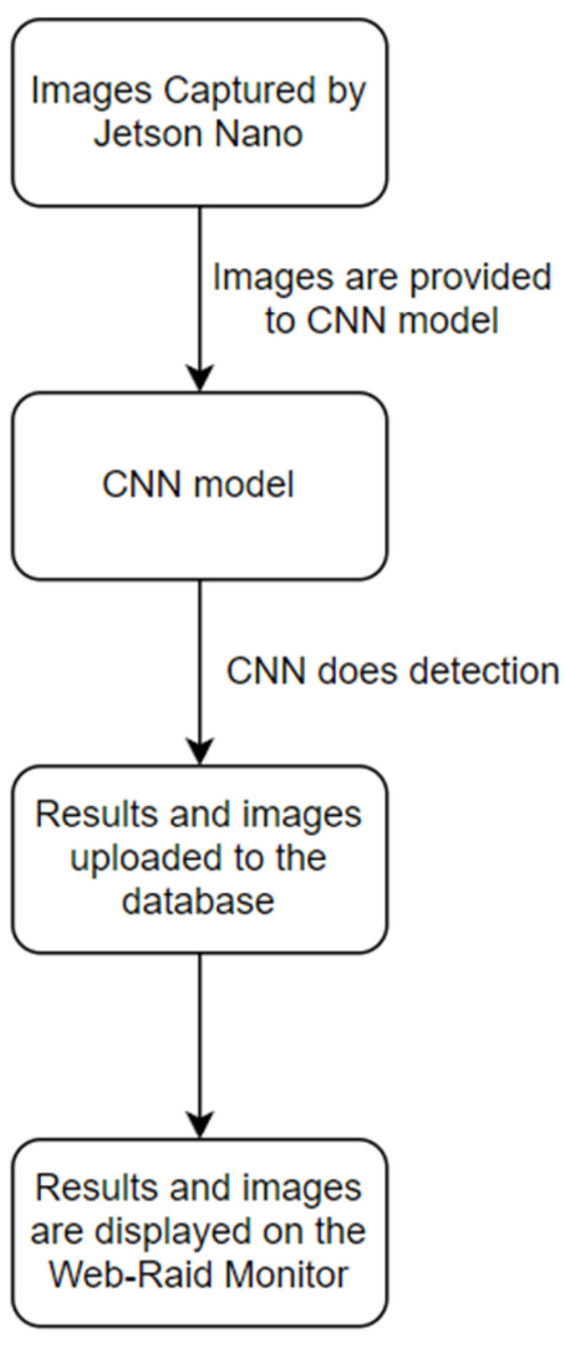
Figure 7. General Flow of Web-Raid Monitor